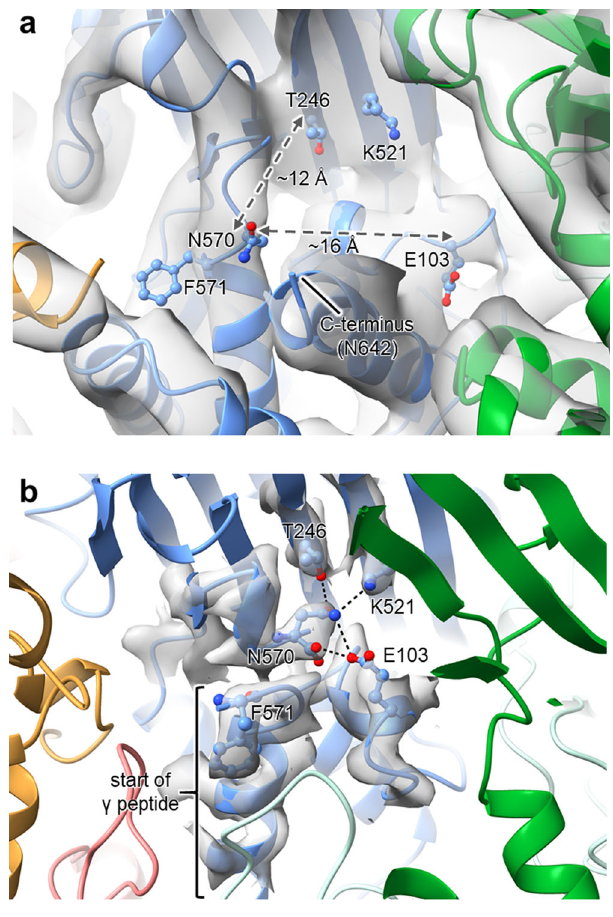
Fig. 8 Structural remodelling at the N ω V autocatalytic cleavage site. Close-up views of the cleavage site regions in the a procapsid and b capsid models revealing how disparate the key catalytic residues, Asn570 and Glu103, are in the procapsid as compared to their juxtaposition in the capsid following cleavage of the γ peptide (important residues are shown in ball-and-stick representation). For both models, the site in the A subunit is shown, which is coloured light blue, with neighbouring subunits depicted in different colours. Also shown are the density maps for the procapsid (6.6 Å resolution) and for the capsid (2.7 Å resolution), although for the latter, only the density associated with the highlighted residues is shown for clarity. Note that due to the low resolution of the procapsid reconstruction, the modelling of atomic coordinates is only approximate, especially for the protein side